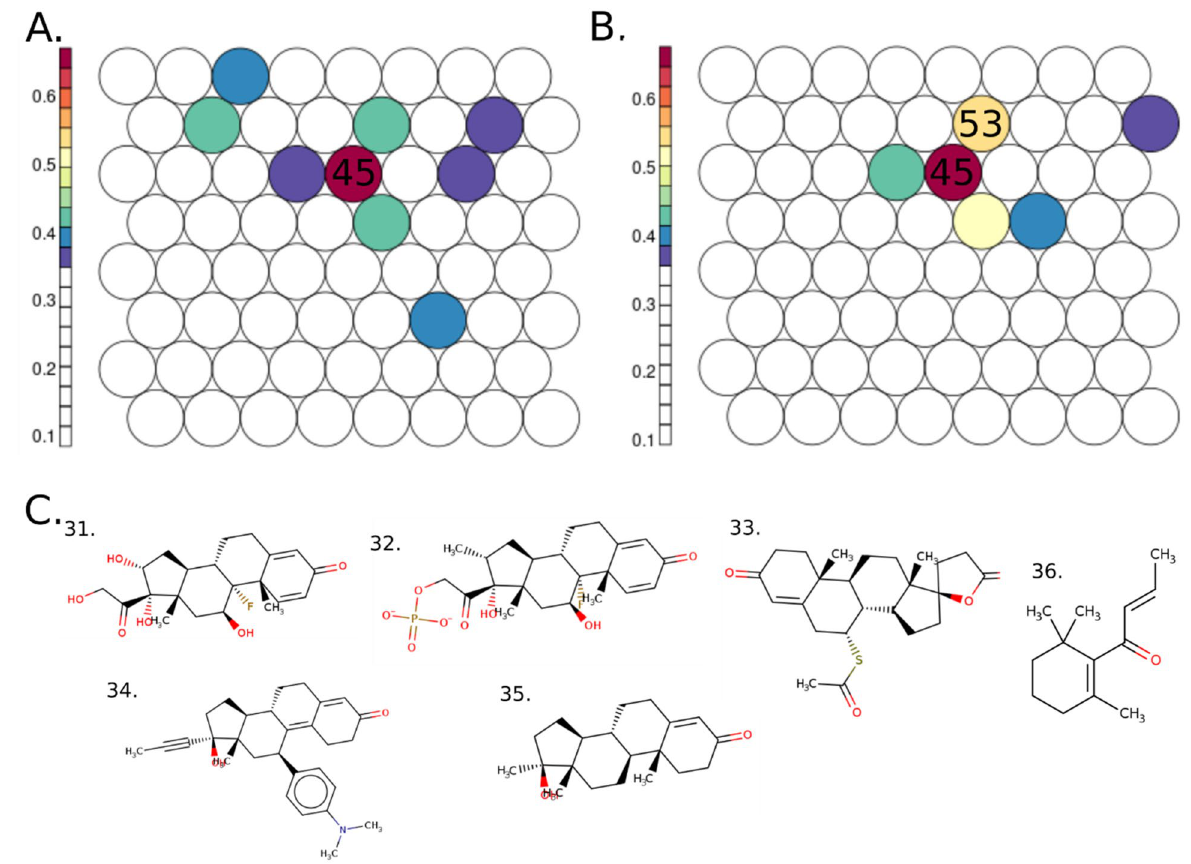
Figure 5. Structure based SOM on the H295R set including 64 clusters colored ( A ) using the average similarity score by cluster for E2 and ( B ) using the average similarity score by cluster for P4. Structures of E2up and P4up chemicals in clusters 45 and 53 are represented. Cluster 45: 31. Triamcinolone (124–94–7), 32. Dexamethasone sodium phosphate (2392–39–4), 33. Spironolactone (52–01–7), 34. Mifepristone (84,371–65–3) and 35. 17-methyltestosterone (58–18-4); cluster 53: 36. (E)-beta-damascone